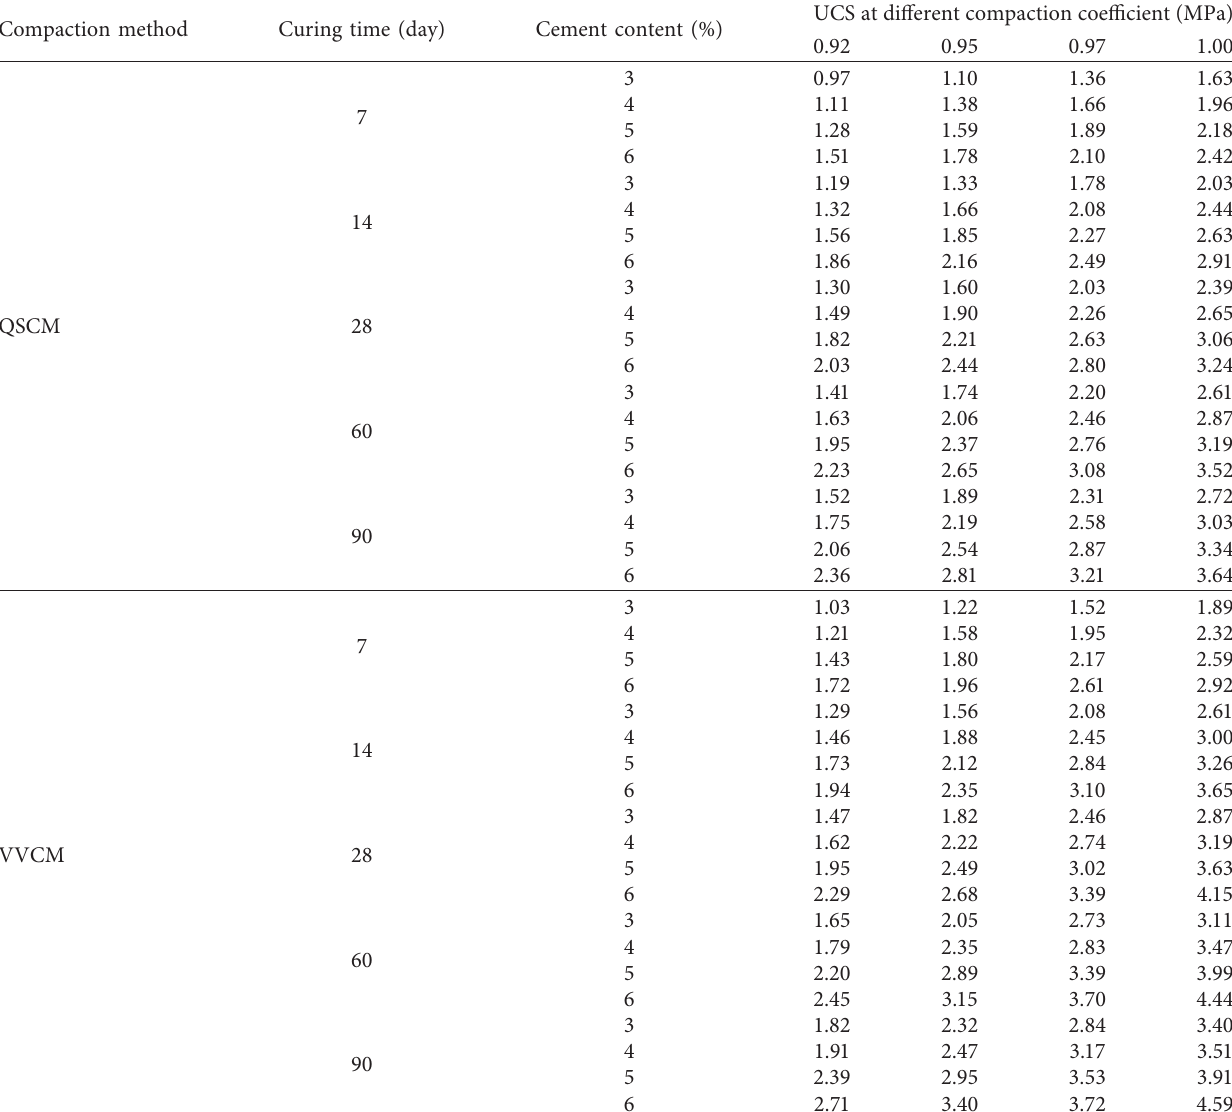
Table 6: Unconfined compressive strength of CSL compacted using VVCM and